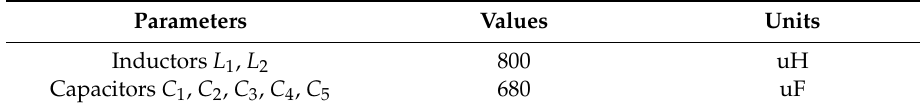
Table 2. Parameters table of inductors and capacitors.